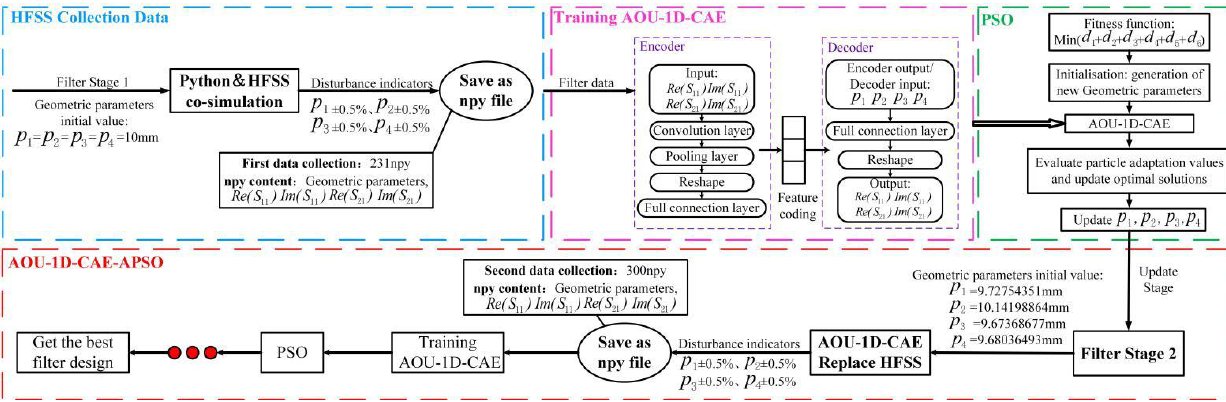
Table 1. Fourth-order cavity filter optimization process.